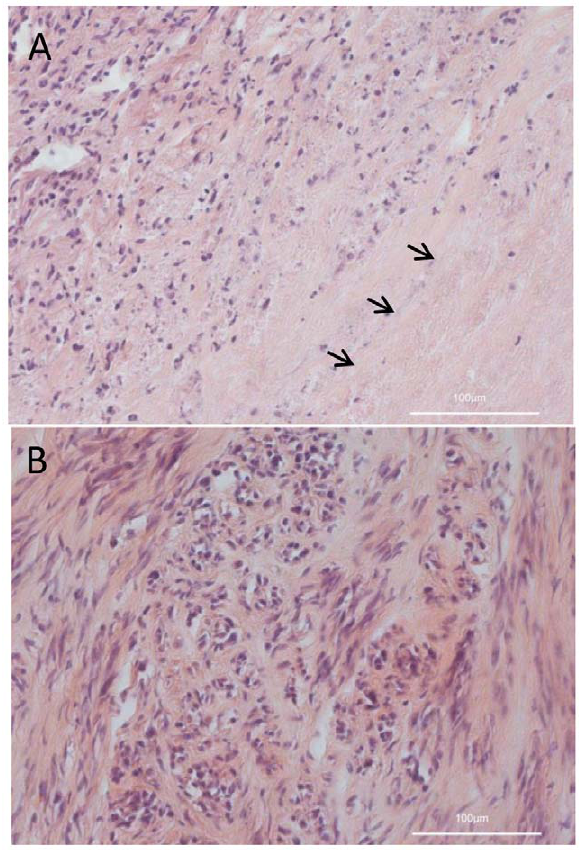
Figure 10. Histological analysis of LIVP1.1.1-infected (A) and non-infected (B) STSA-1 xenograft tumors, 21 dpvi (H&E, bars, 100 m m). Necrotic area is marked by arrows.